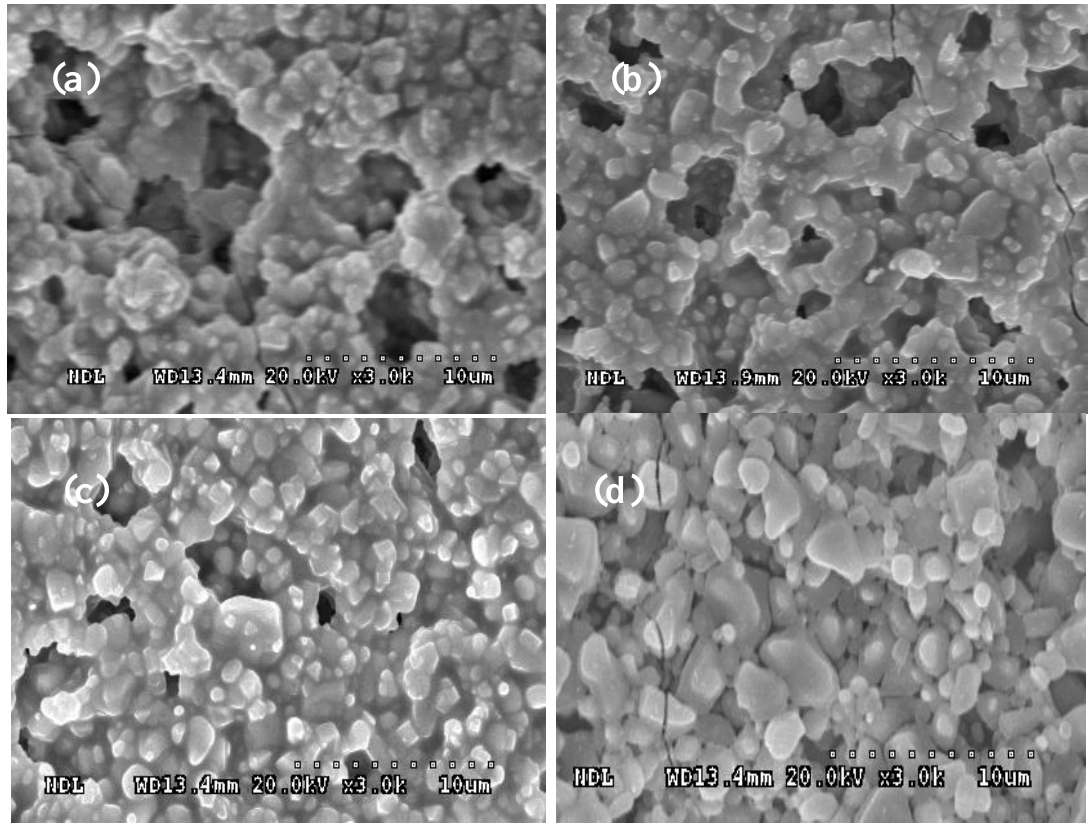
Figure 4. Surface morphologies of screen-printed SPTB on p-type Si(100) substrates fired